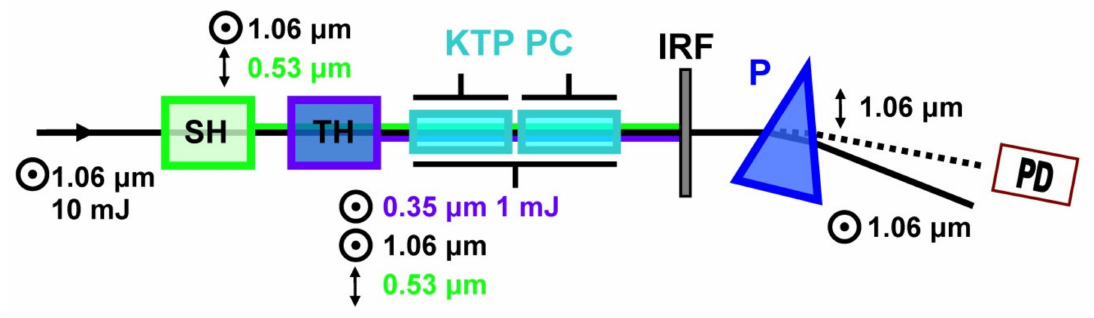
Figure 10. Experimental scheme of test measurements of depolarization at the Y-cut KTP PC due to third harmonic radiation absorption. SH and TH are second and third harmonic nonlinear crystals, IRF is the infrared filter, P is the polarizing calcite prism, radiation polarizations are indicated by arrows and dotted